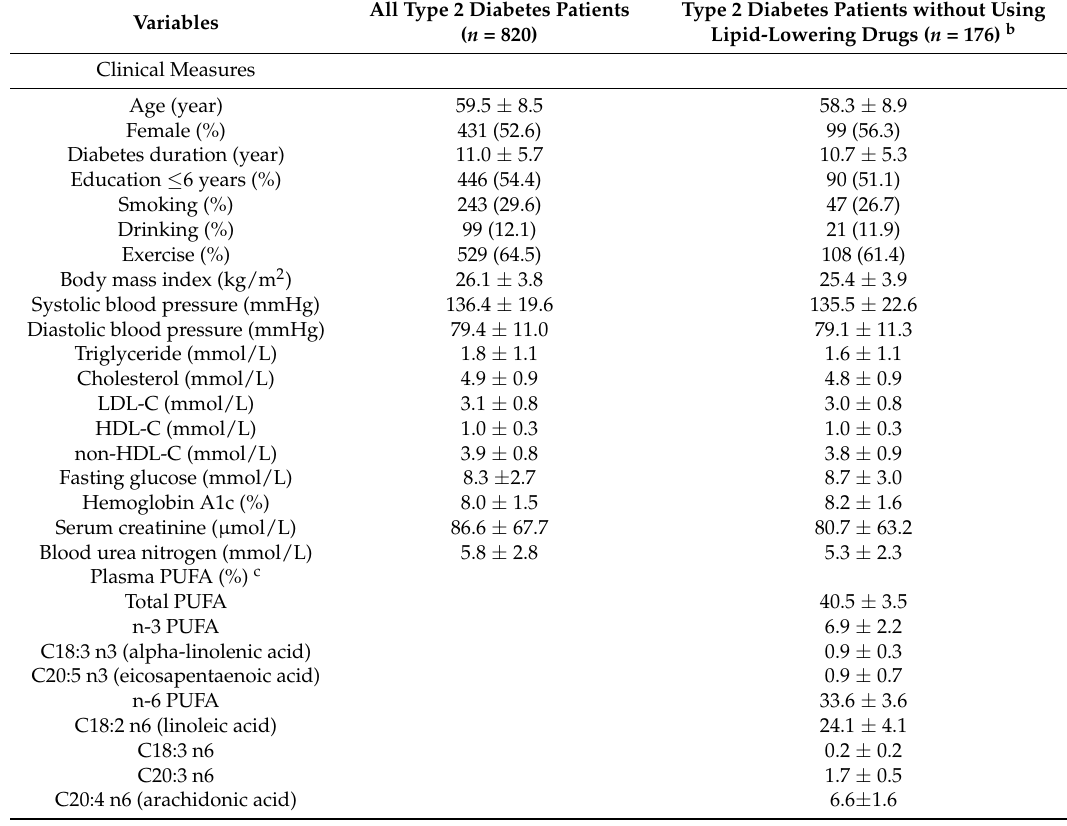
Table 1. Baseline characteristics of 820 type 2 diabetes patients and those who without using lipid-lowering drugs ( n = 176) a